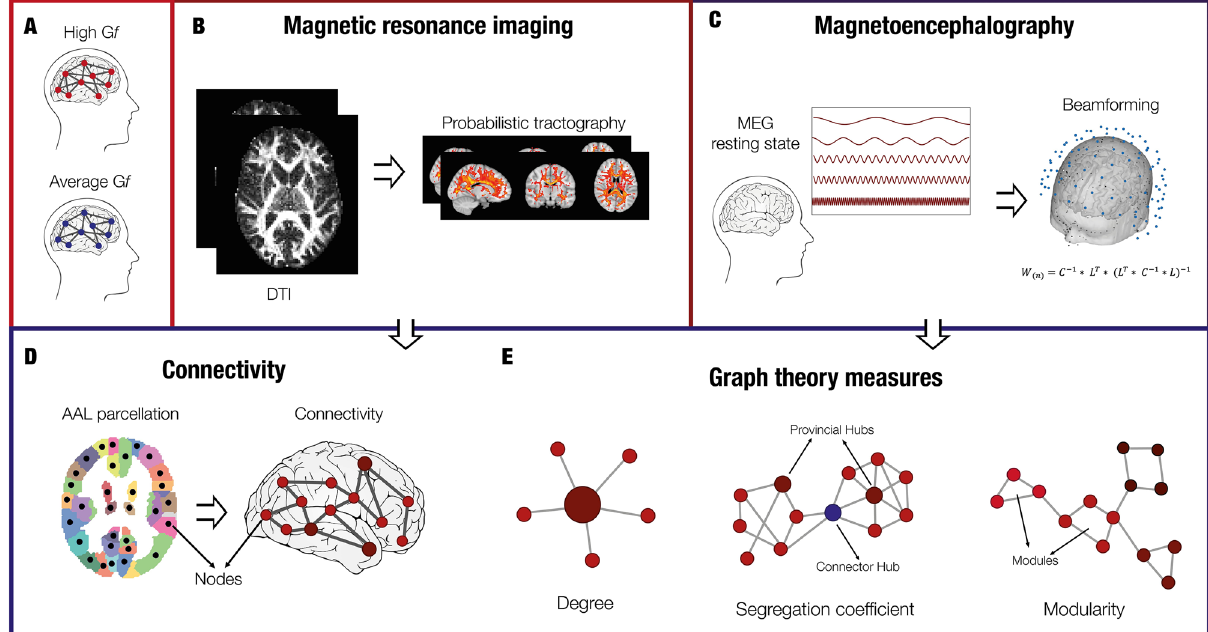
Figure 1. Experimental design and analysis pipeline. ( A ) Participants were divided into two experimental groups, namely average Gf and high Gf, based on their scoring to perceptual reasoning, working memory, and speed processing indexed by WAIS-IV. ( B ) Diffusion-tensor imaging (DTI) data were collected and pre- processed for both groups. Then, the white matter bundles were modelled using probabilistic tractography. ( C ) For both groups, magnetoencephalographic (MEG) data were collected during a 10-min session of resting state. The data were filtered to analyse five different frequency bands: 0.1–2 Hz (delta), 2–8 Hz (theta), 8–12 Hz (alpha), 12–32 Hz (beta), 32–74 Hz (gamma). Next, they were source-reconstructed with the beamforming algorithm. ( D ) Connectivity was computed for both DTI and MEG data for each subject. The connectivity matrix for the DTI data was created by computing the probabilistic tractography based on AAL parcellation. The connectivity matrix for MEG data was estimated by computing the Pearson’s correlations between the envelope of each pair of brain areas timeseries. ( E ) Graph measures were used to investigate the structural and functional brain networks of each group. Degree, modularity, and segregation coefficient provided the most insightful